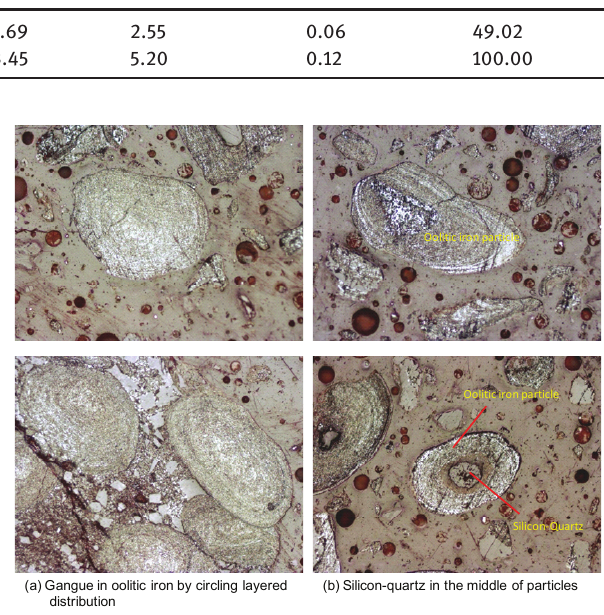
Figure 1: Illustration of (a) gangue, and (b) silicon within the raw oolitic iron ore.